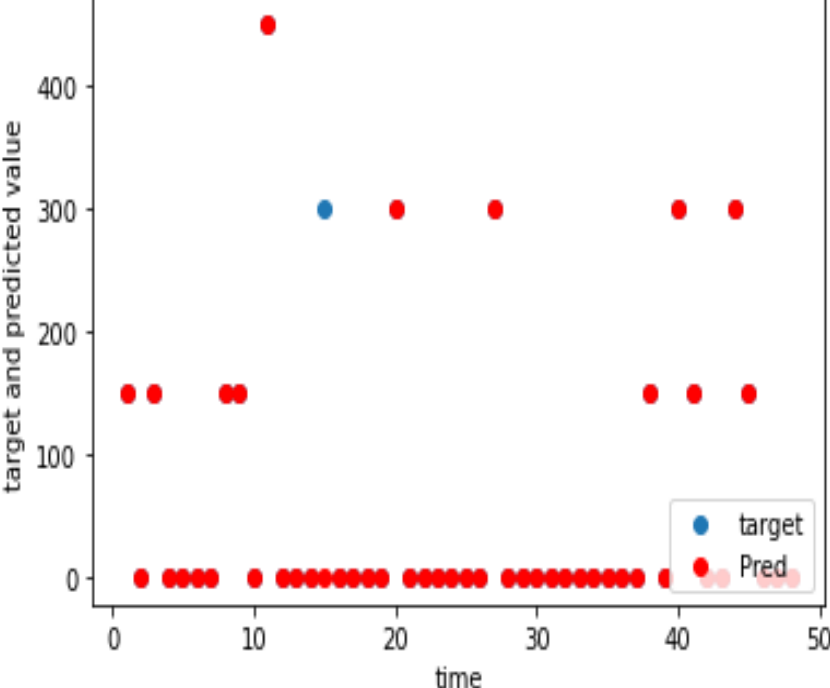
Figure 6. Charging demand prediction of a weekend for Matinkylä (M).